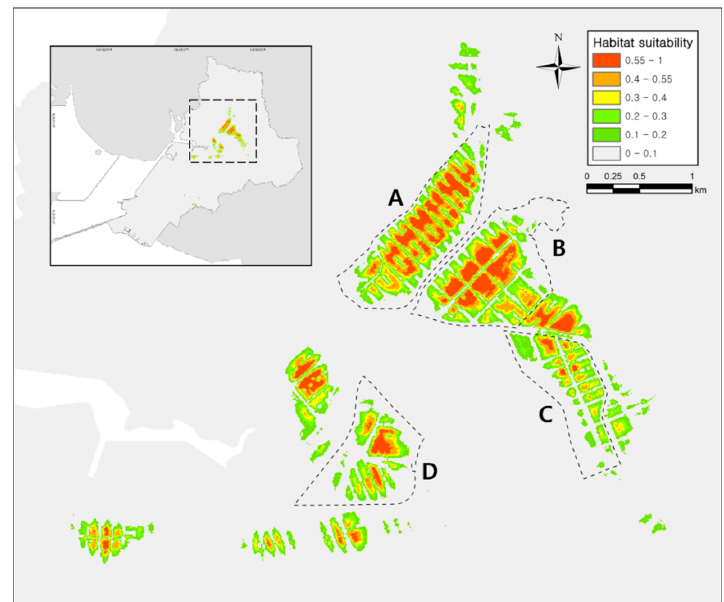
Figure 2. Result of Dryophytes suweonensis distribution model for Hojobeol, Siheung, in the Republic of Korea. Our analysis highlights 0.55 as the threshold above which an area was suitable for D. suweonensis . Sites ( A ) and ( B ) contain the largest suitable while sites ( C ) and ( D ) are less suitable for the species. For the variable rice paddy cover, habitat suitability increased with the size of the area of connected rice paddy, until reaching a plateau phase at 0.19 km 2 (Figure 3). The species was found in areas with a rice paddy cover of at least 0.12 km 2 . The closer to a paved road, the less suitable the habitat was for D. suweonensis and paved roads had an effect over 1 km. NDVI had a positive relationship with habitat suitability of D. suweonensis , until reaching a plateau phase at about 0.65 and the species was estimated to be able to exploit habitats with values ranging from 0 to 0.78, although individuals were observed at sites with values between 0.31 to 0.73. The habitat was determined to be suitable for the species up to 500 m away from freshwater but habitat suitability also decreased with distance from freshwater. Habitat suitability was also higher when close to forests, with a threshold in impact until 600 m. Regarding slope and altitude, the lowest values were associated with higher habitat suitability for D. suweonensis (Table 1).